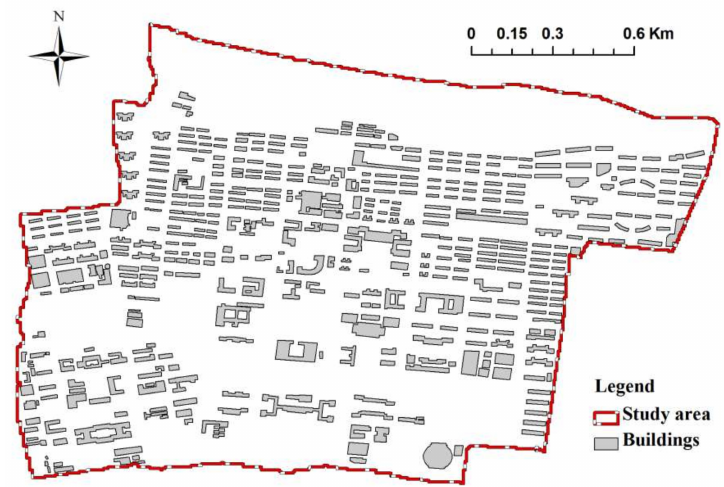
Figure 6. The geometry of buildings in the study area.